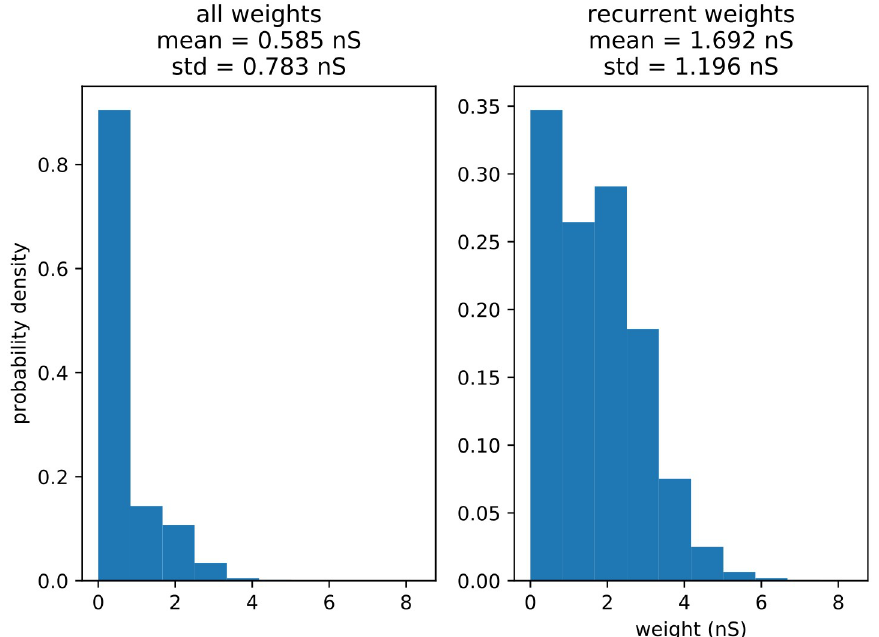
Fig 7. Connection strength histograms. Strength histograms of all connections (i.e. for the whole excitatory matrix) (A), and trained recurrent connections (within clusters) (B), along with means and standard deviations for each